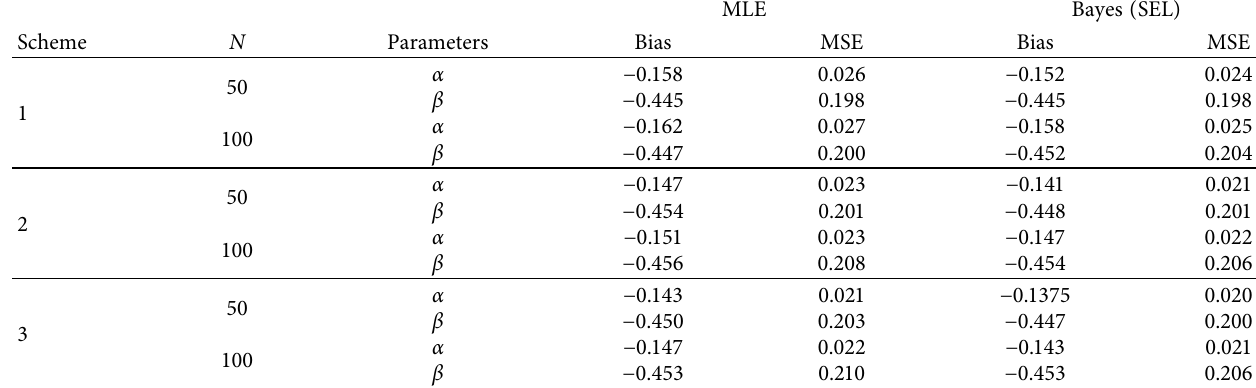
Table 1: MSEs and biases for MLEs and Bayes estimators of α � 0 . 5 and β � 0 . 5.